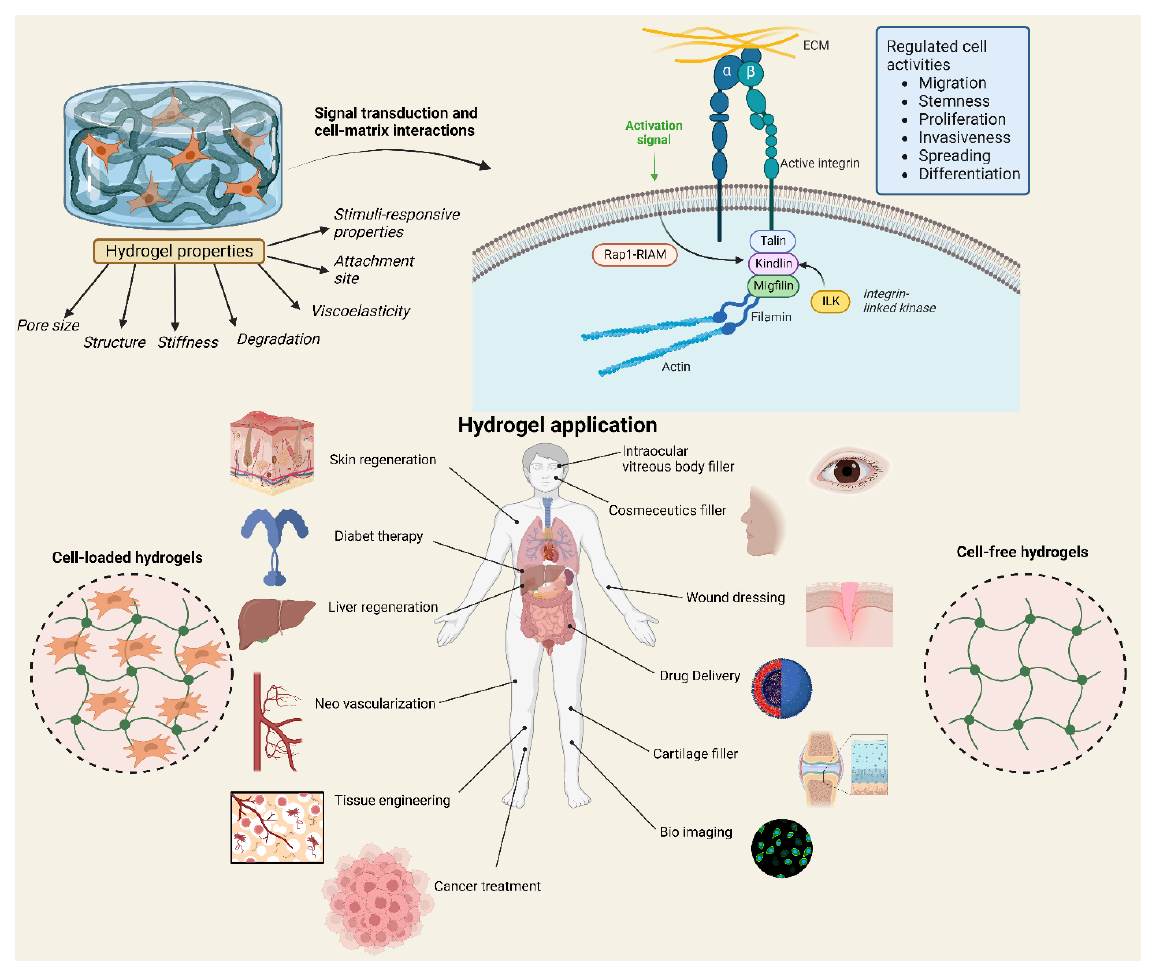
Figure 2. Hydrogel biomedical applications, properties, and interaction with cells.